Question: What style of plot is this figure drawn as?
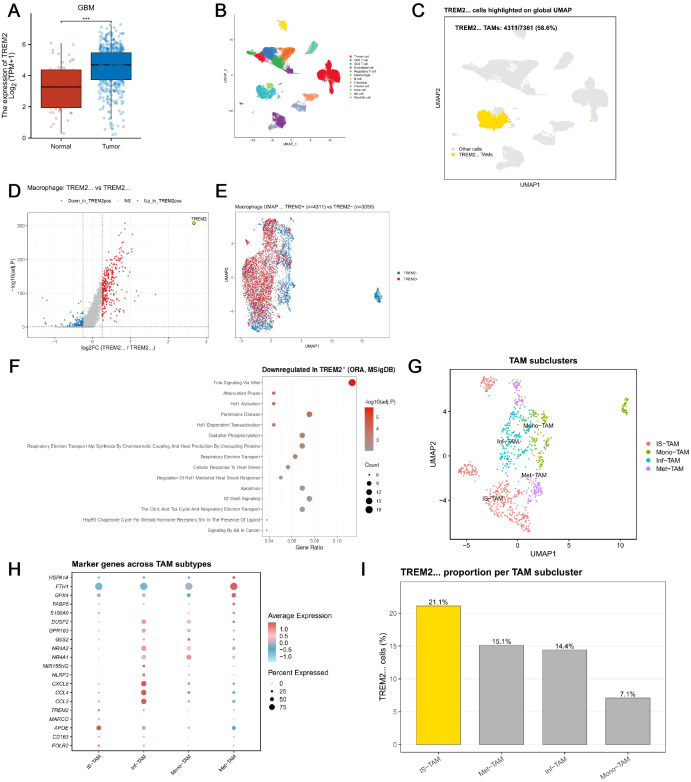
Answer: scatter